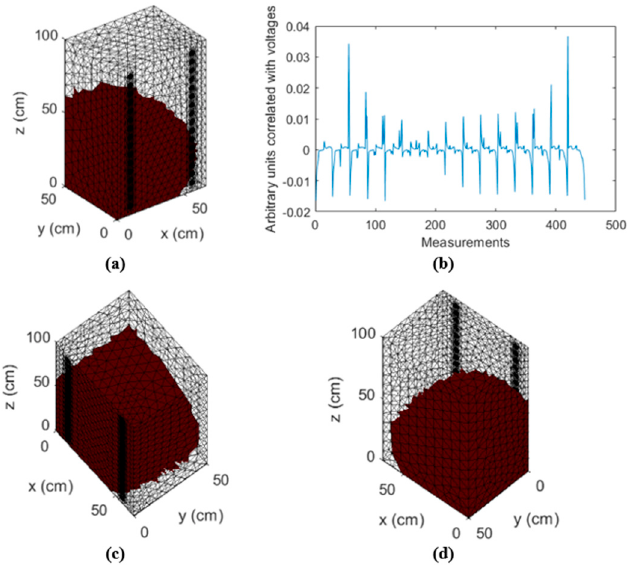
Figure 10. View of the measurement vector and the corresponding reconstructions: ( a )—electrodes on the right, ( b )—measurement values, ( c )—electrodes on the left, ( d )—electrodes on the back.